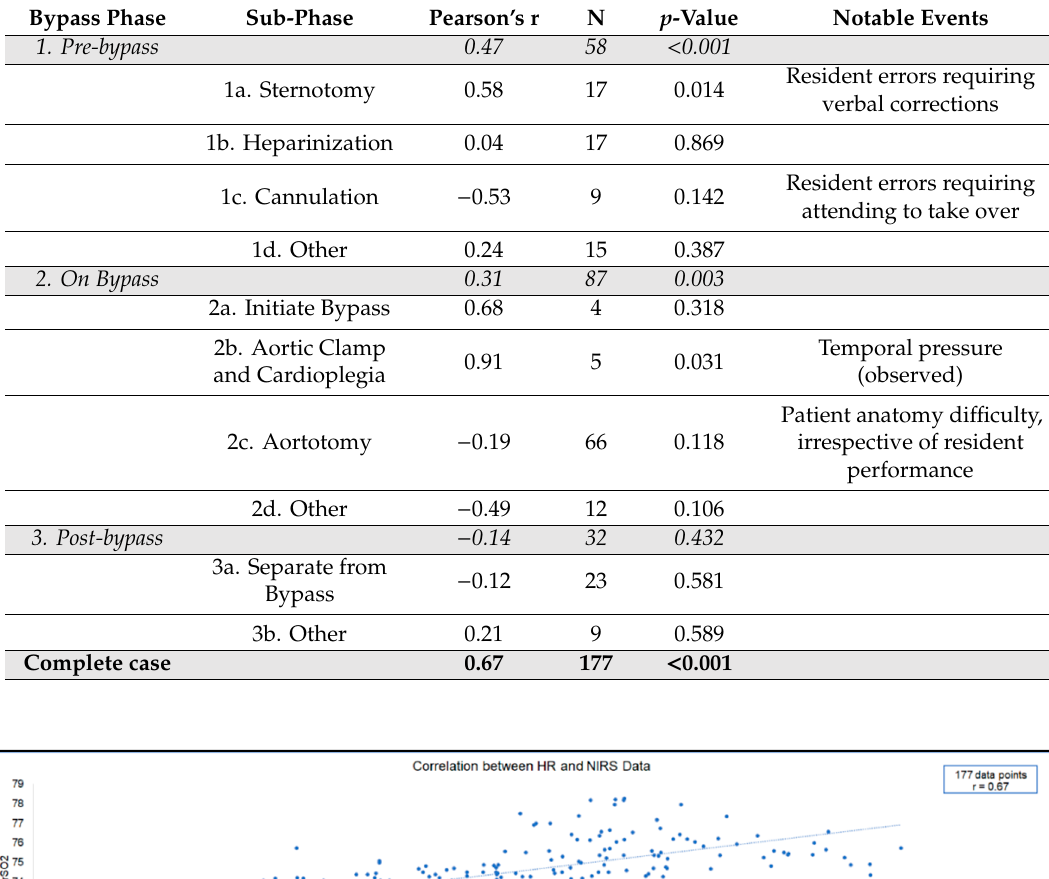
Figure 2. NIRS acquisition device placement in relation to the attending surgeon and cardiopulmonary bypass pump. A. highlights the preamplifier and B. highlights the INVOS™ monitor receiving data from the sensors.